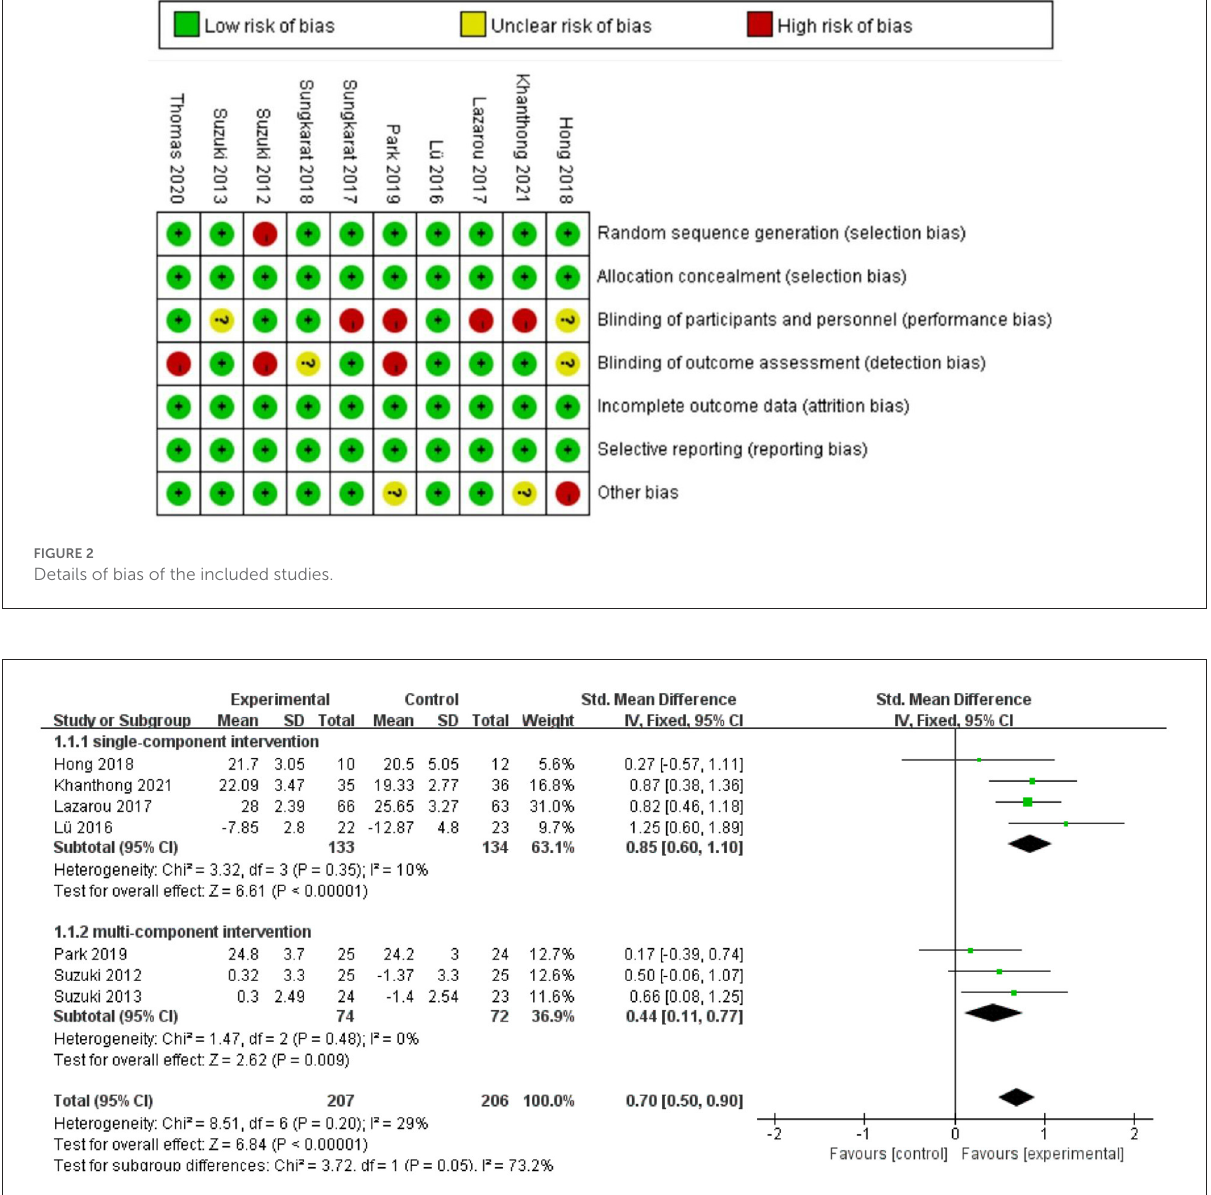
FIGURE3 The influence of exercise interventions on global cognitive